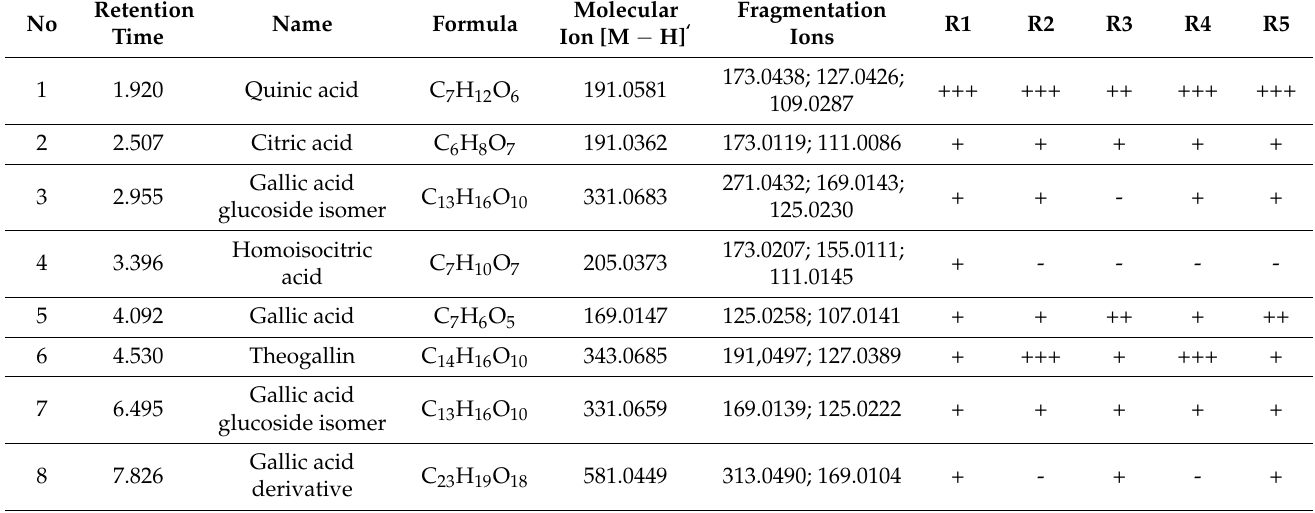
Table 2. Compounds found in R. platyacantha R1–R5 extracts after HPLC/ESI-QTOF-MS analysis in negative ion mode; the relative content of identified compounds was indicated as high (+++), moderate (++), or low (+) based on the peak’s surface area in corresponding chromatograms (Figure